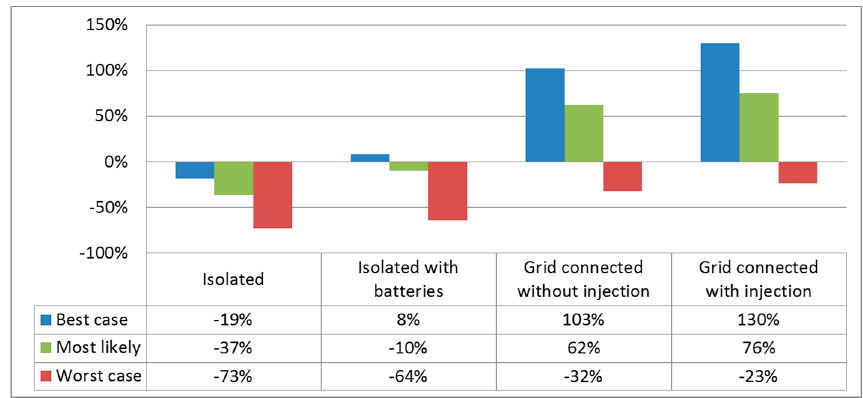
Figure 10. Most likely percentage of relative variation of self-consumption potential in Spain by type and scenario with respect to static (own elaboration).